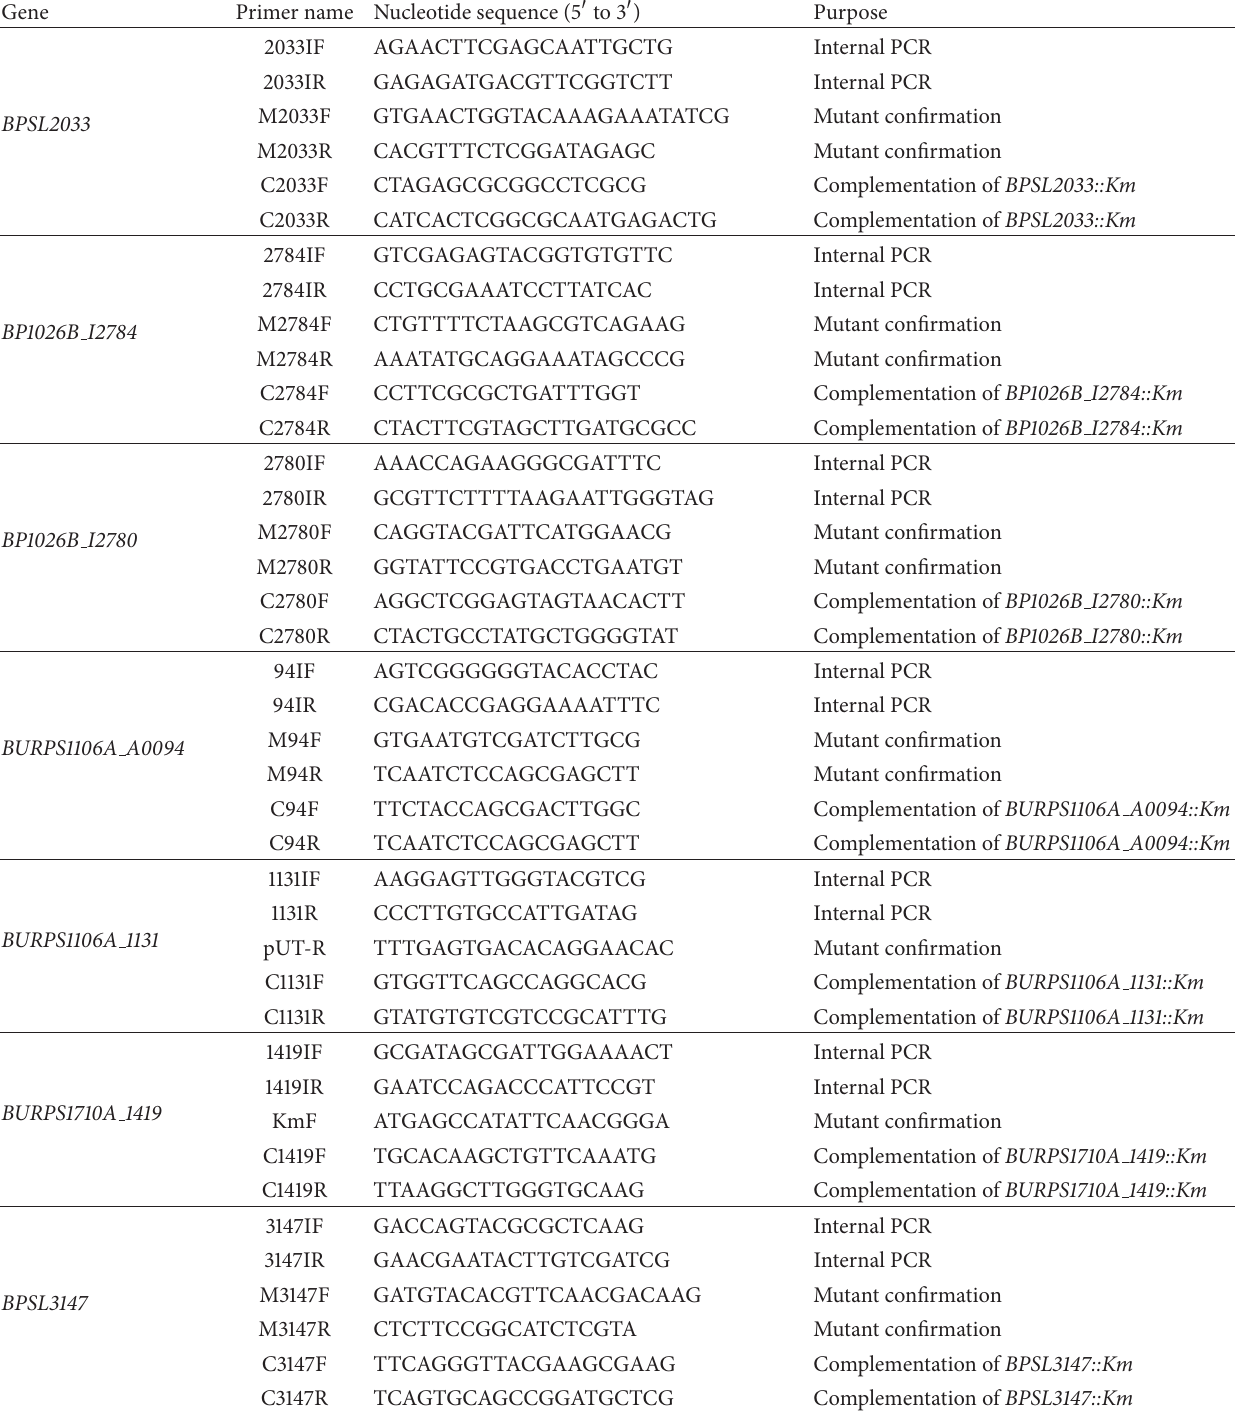
Table 2: Primers used for PCR and construction of mutants and complemented plasmids.